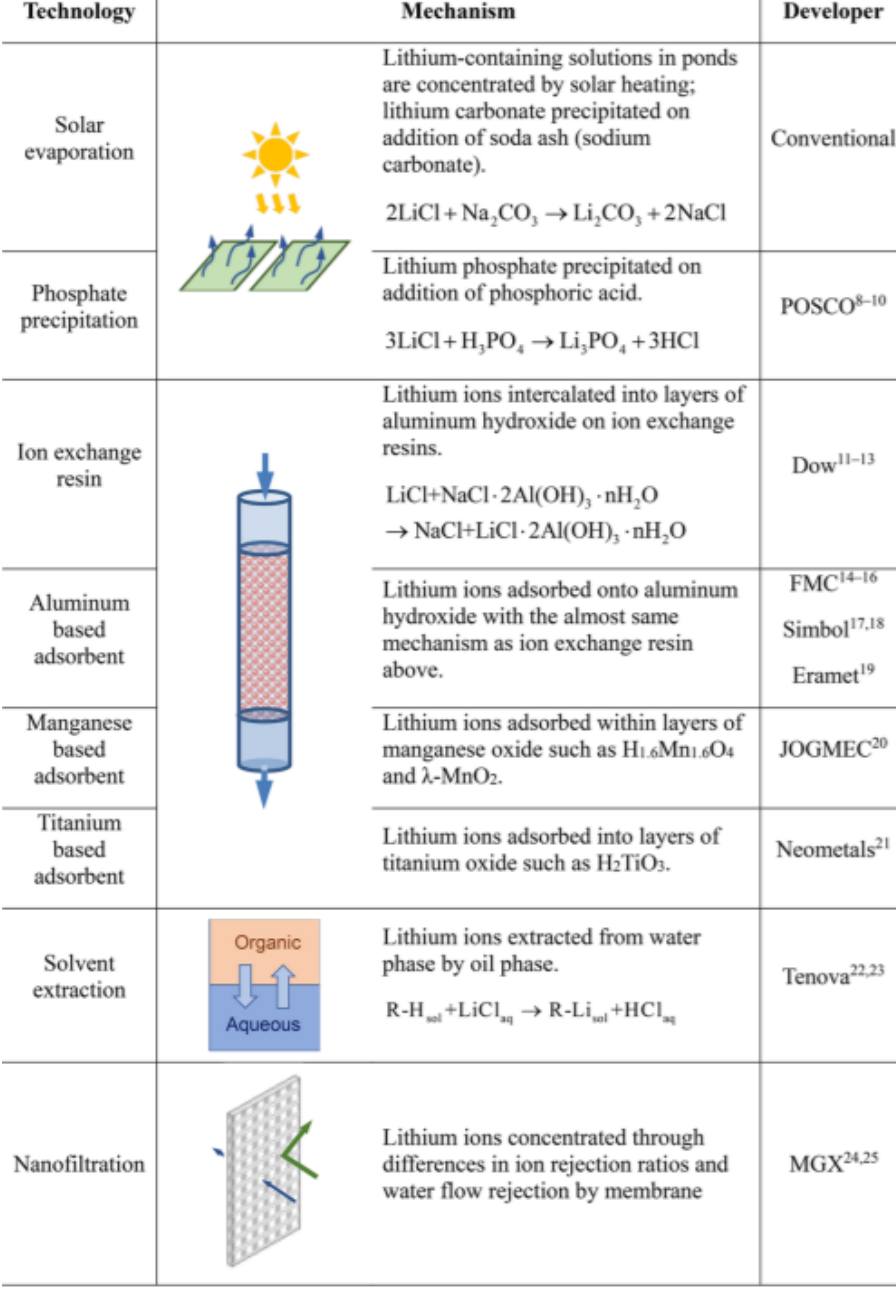
Figure 4. Available technologies for extracting Li from brines. Description of the mechanism of extraction for Li of the several commercial technologies and their developers